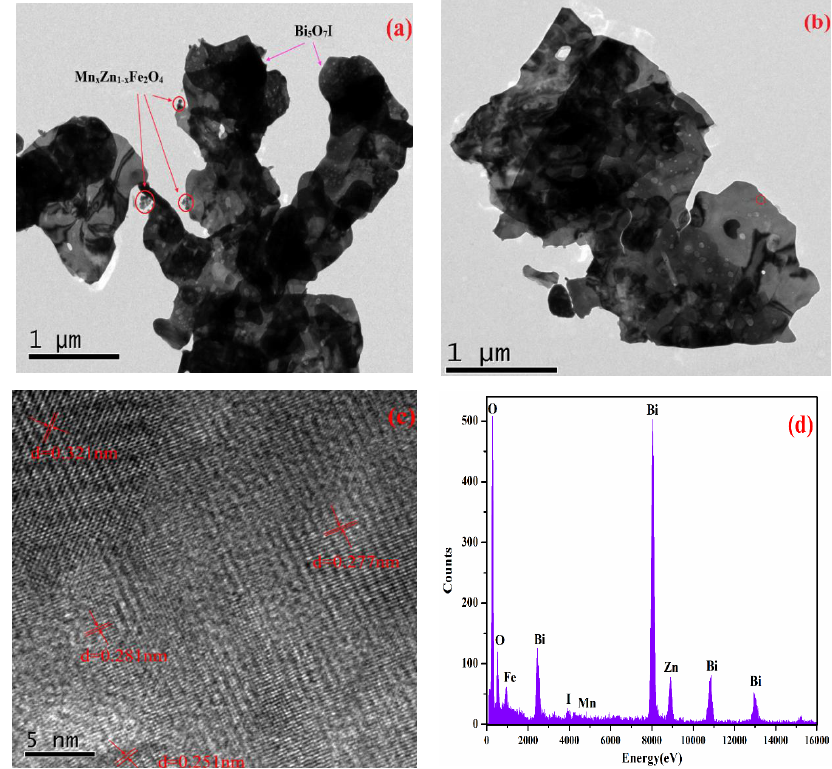
Figure 5. ( a , b ) TEM image of Bi 5 O 7 I/Mn x Zn 1 − x Fe 2 O 4 ; ( c ) high-resolution TEM (HRTEM) image of Bi 5 O 7 I/Mn x Zn 1 − x Fe 2 O 4 ; ( d ) EDS spectrum of Bi 5 O 7 I/Mn x Zn 1 − x Fe 2 O 4